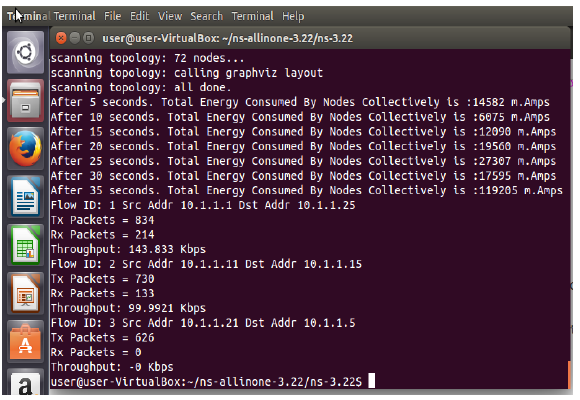
Figure 9. Energy-Utilization w.r.t.